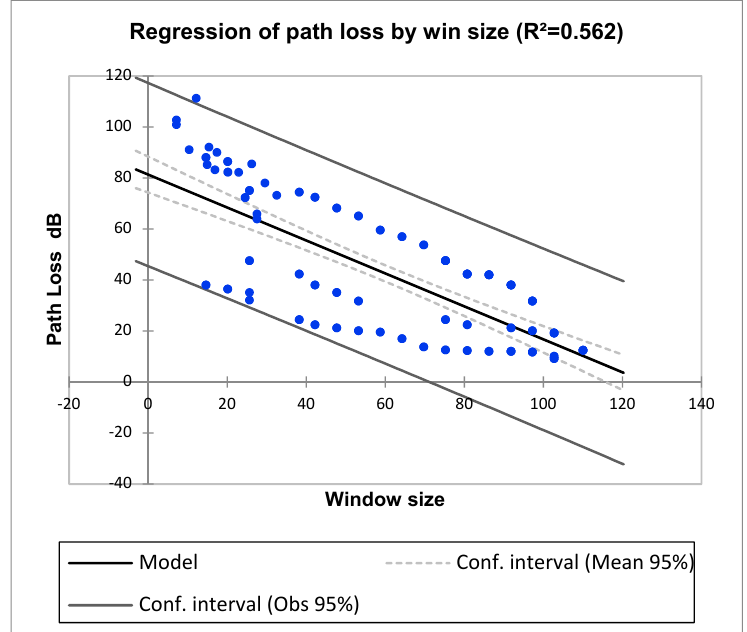
Figure 4. Regression of path loss by the window size.